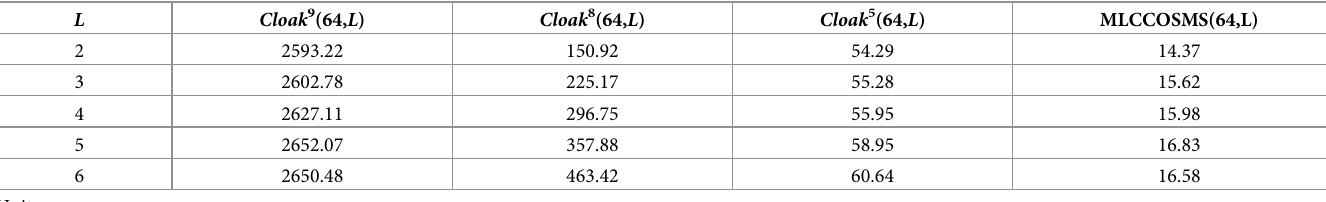
Table 4. Durations of conveying a codeword by several Cloak s and MLCCOSMS with different numbers of links.